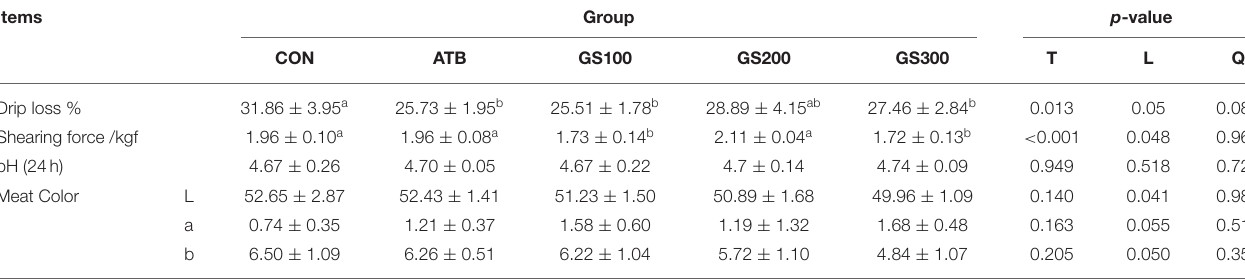
TABLE 5 | Effects of ginsenoside Rg1 on breast meat quality of broiler chickens ( n = 6). Items